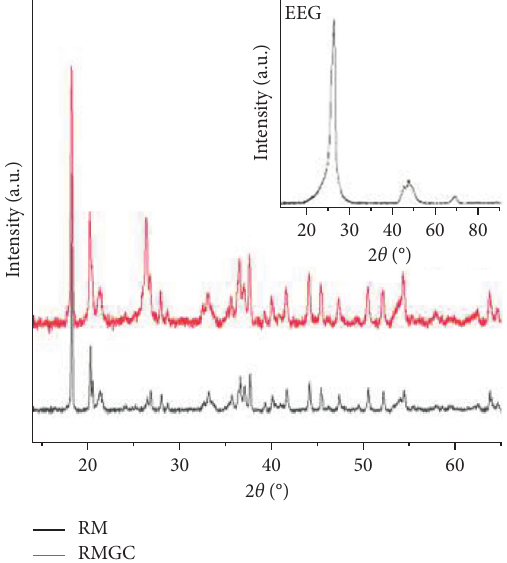
Figure 2: TEM image of RMGC, EDS spectrum of